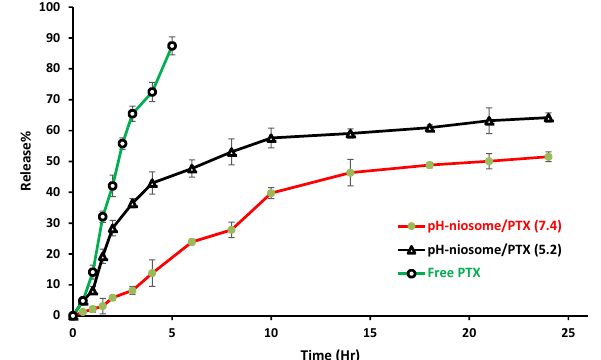
Fig. 4 Release (%) of PTX from pH-responsive PTX/niosome in PBS solution with different pH levels of 5.2, and 7.4 at 37 °C. Points, mean ( n = 3); bars,